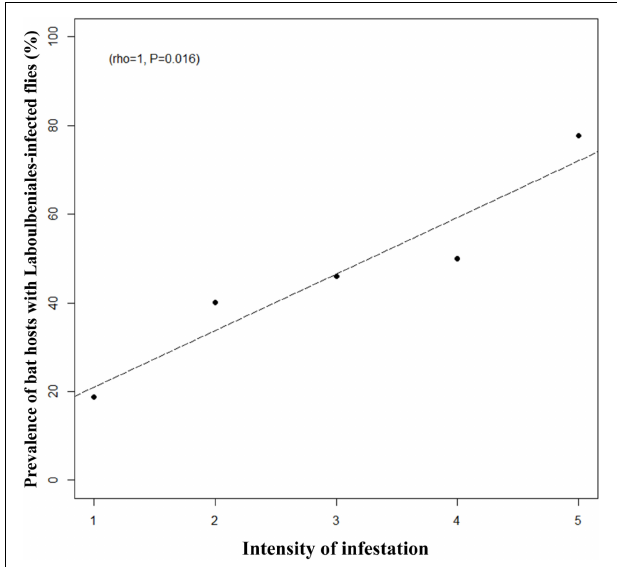
FIGURE 2 | Correlation between bat fly intensity on bats hosts and the prevalence of bat hosts with Laboulbeniales-infected bat flies. Based on subset data for Penicillidia conspicua and Pe. dufourii .